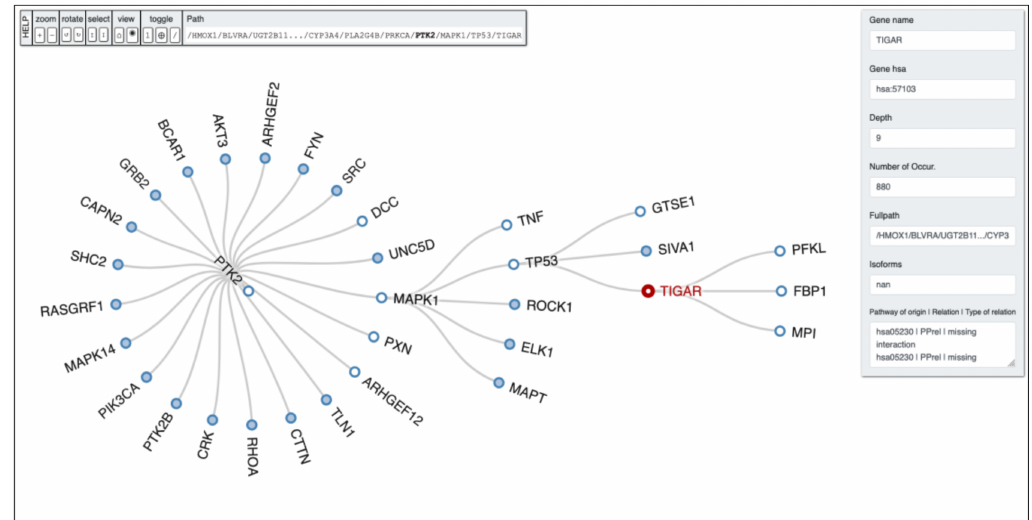
Figure 4. PETAL output tree obtained by running the depth-first search algorithm with a depth equal to 10 retrieved from the KEGG database (hsa00860) with TIGAR as target